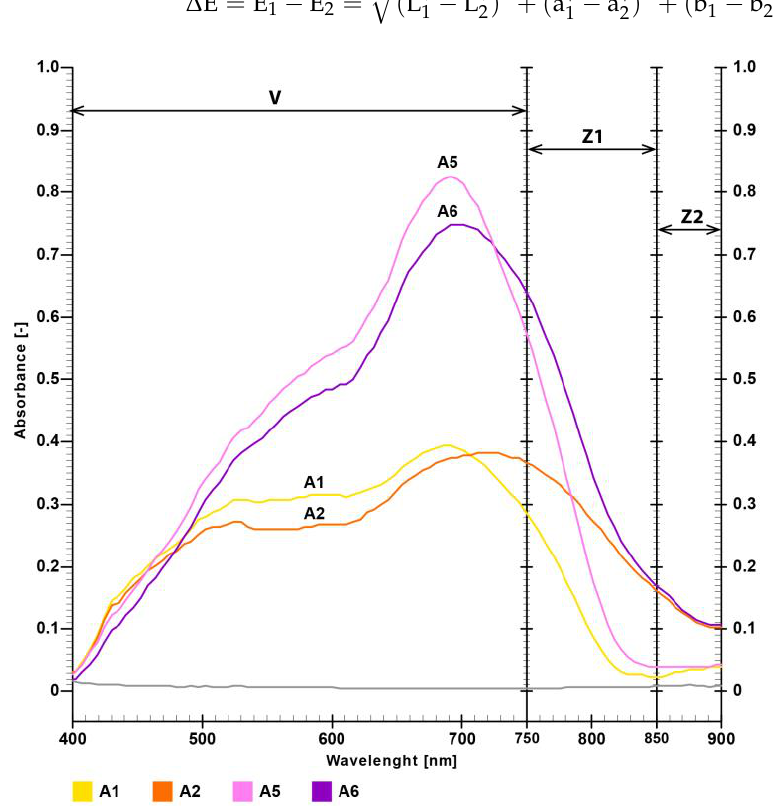
Figure 11. Comparison of the spectrographs for the Drab and Blue process twin dyes.